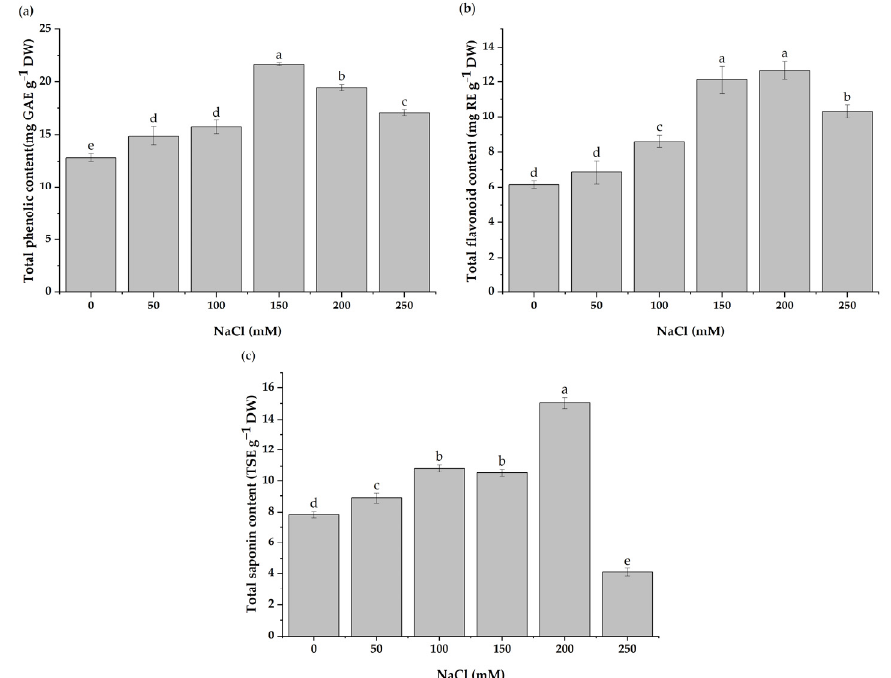
Figure 5. Changes in ( a ) the total phenolic contents, ( b ) total flavonoid contents, and ( c ) total saponin contents under different levels of salt stress (0, 50, 100, 150, 200, and 250 mM of NaCl). The values presented are means ± SD ( n = 3). Different letters (a–e) above the bars indicate a significant difference between treatments according to the Duncan test ( p < 0.05).